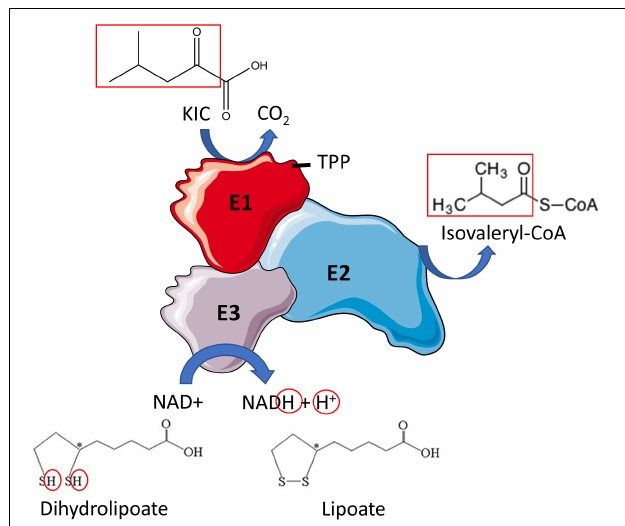
FIGURE 5 | Branched-chain ketoacid dehydrogenase reaction. Oxidative decarboxylation of the branched-chain ketoacid (BCKA) (shown here for ketoisocaproic acid) is initiated when the E1 subunit of BCKDH binds thiamine pyrophosphate (TPP). An acyl group is formed (both red boxes) which is simultaneously transferred to E2, where it is attached to coenzyme A (CoA). Lipoate is oxidized in the process, producing dihydrolipoate. E3 reduces dihydrolipoate producing lipoate and NADH + H + . Then the metabolites of the BCKAs are metabolized in their respective pathways. Re-drawn and modified from Conway and Hutson